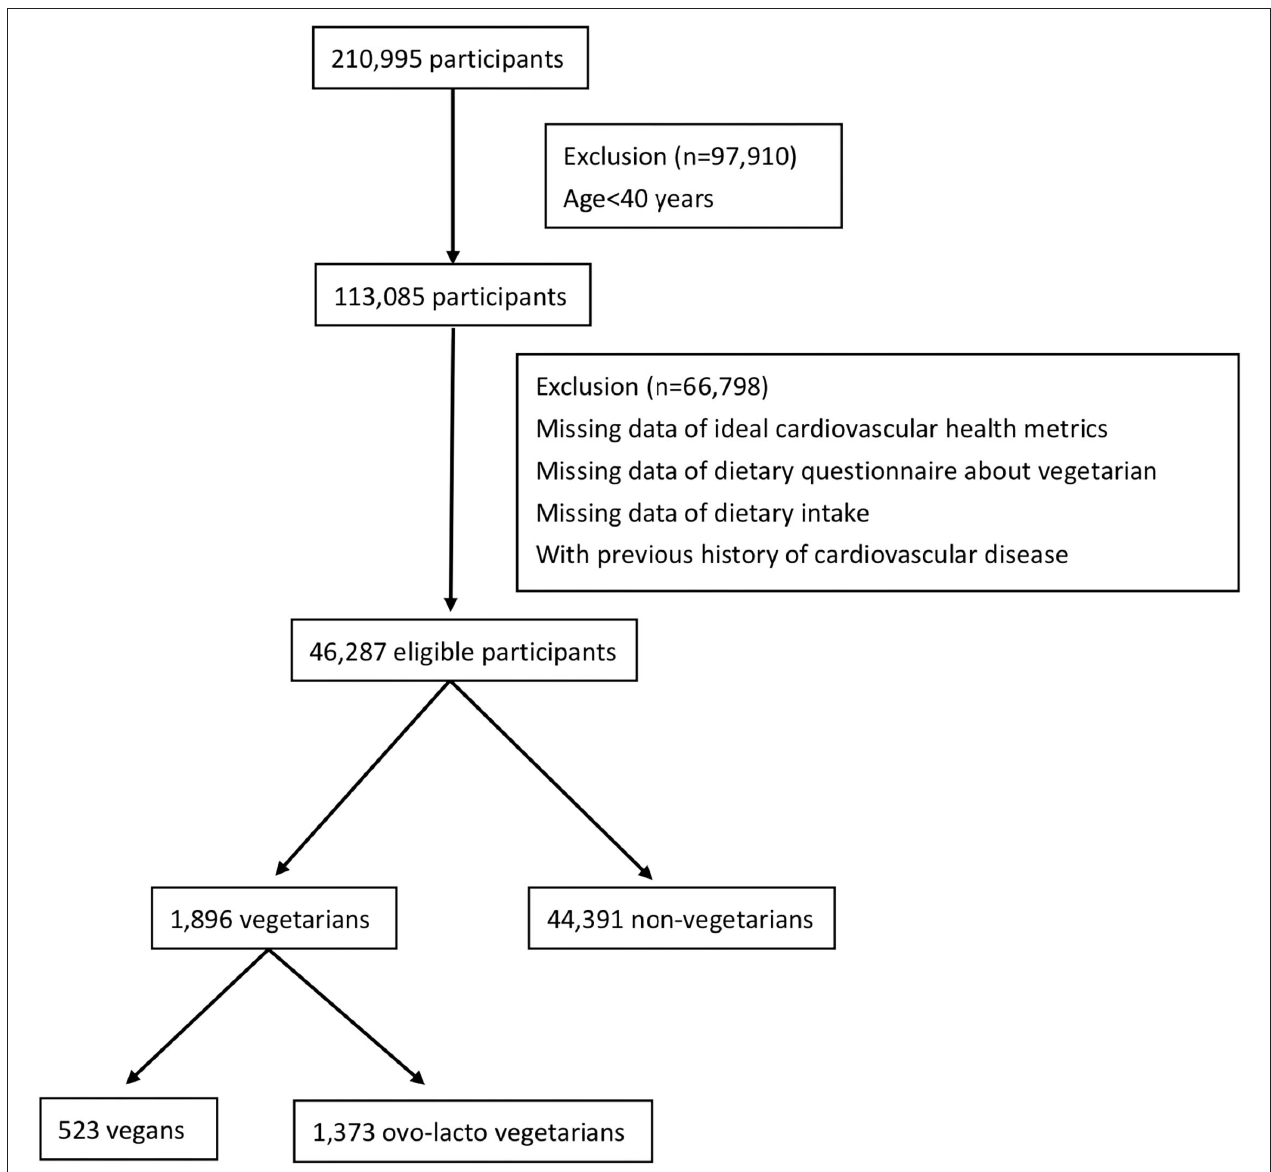
FIGURE 1 | Flow chart of selection of study